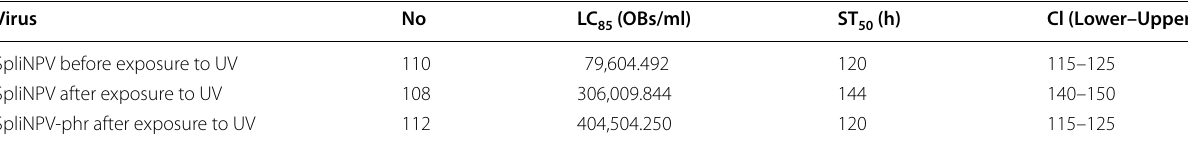
Table 2 Kaplan–Meier estimation of ST50 for Spodoptera littoralis larvae infected with OBs derived from SpliNPV or vSpli-phr in a single infection